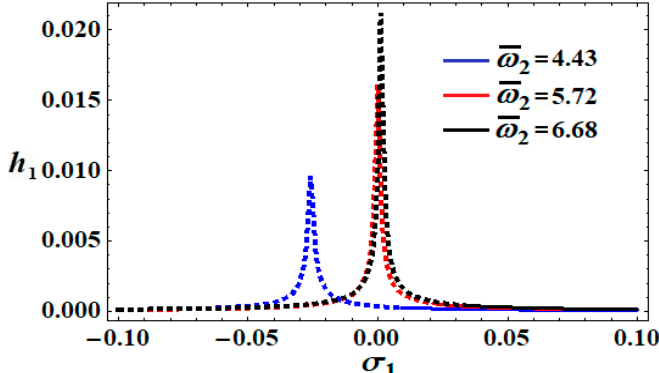
Figure 12. The variation of the frequency response h 5.72,6.68) .